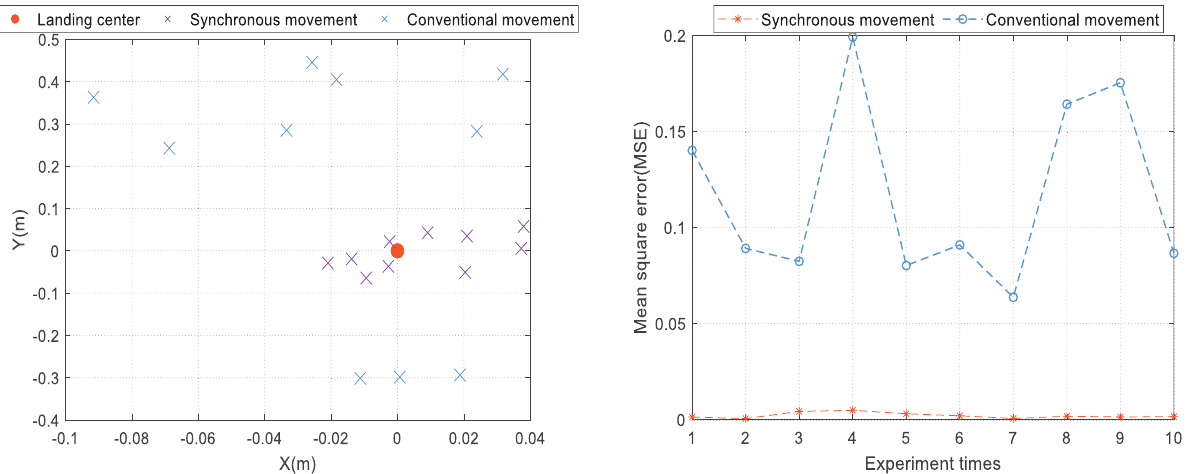
Figure 16. Landing accuracy of UAV–USV synchronous movement and conventional movement under the condition of USV roll